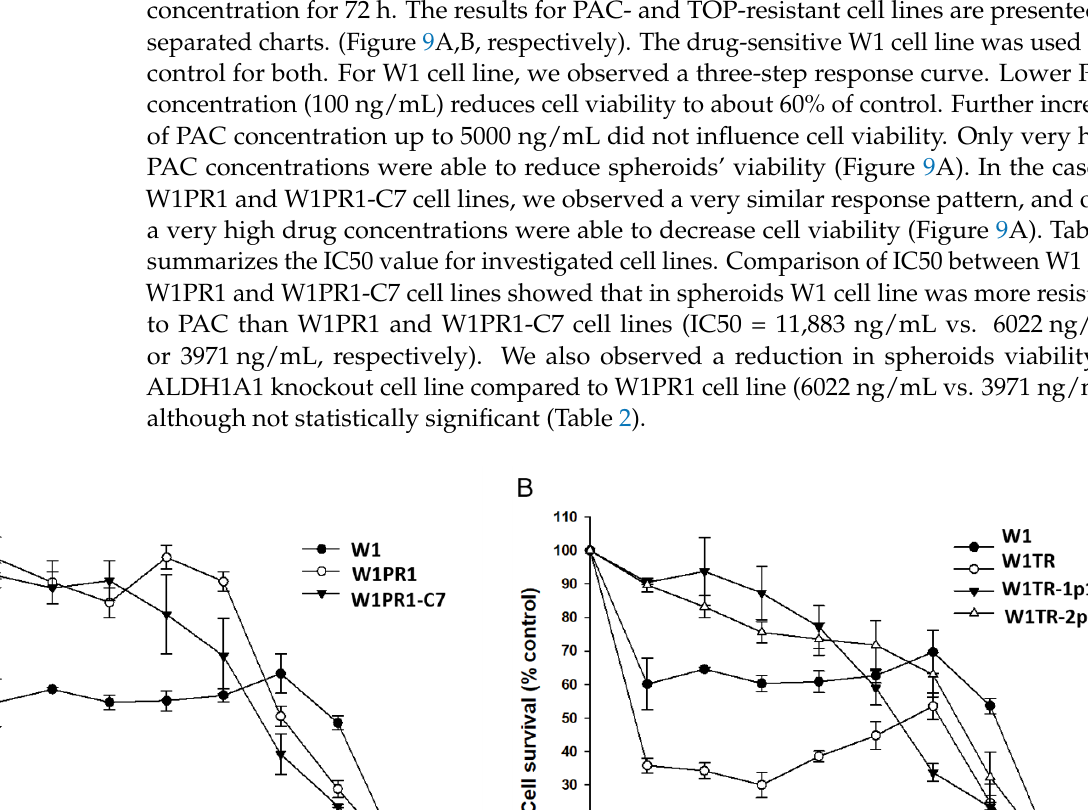
Table 2. Summary of cell line resistance to PAC (paclitaxel) and TOP (topotecan) in three-dimen- sional (3D) cell culture condition.